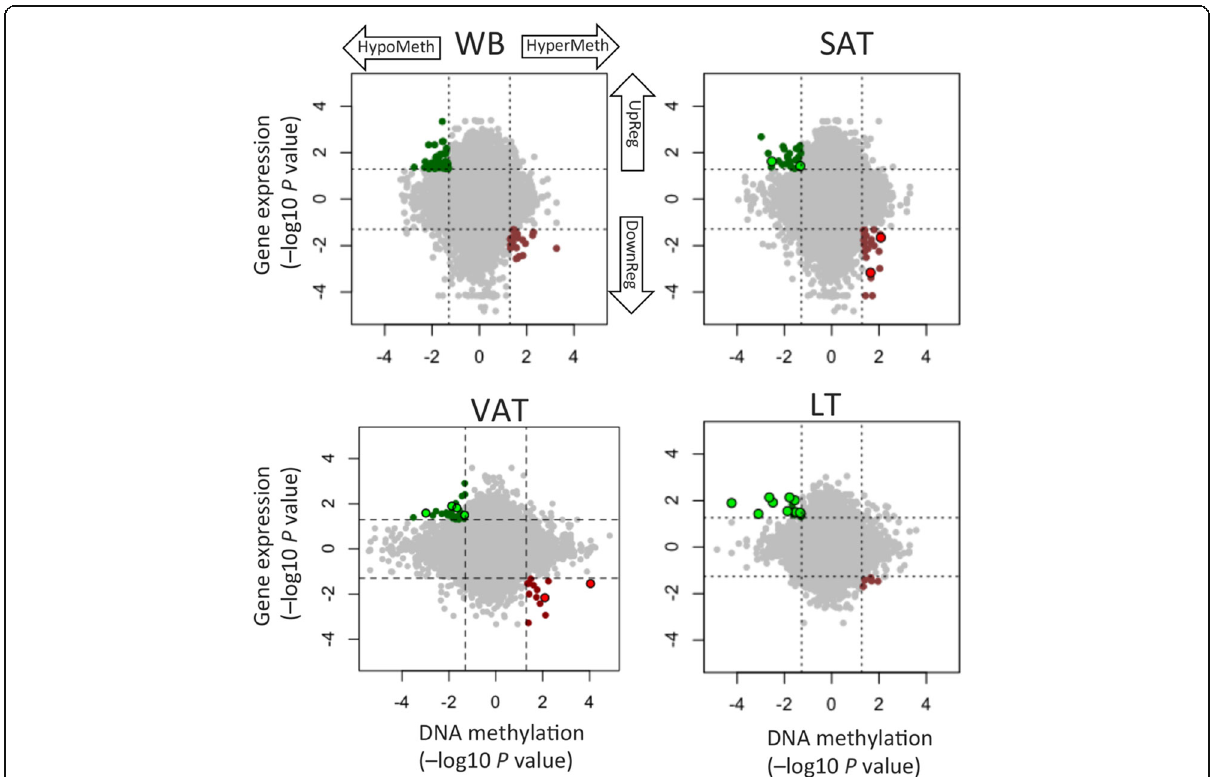
Fig. 2 Starburst plot for the comparison of DNA methylation and gene expression. Dashed black lines indicate p value of 0.05. Red points indicate genes that are significantly down-regulated (DownReg) and hypermethylated (HyperMeth). Green points indicate genes that are significantly up-regulated (UpReg) and hypomethylated (HypoMeth). DMCs are highlighted with black